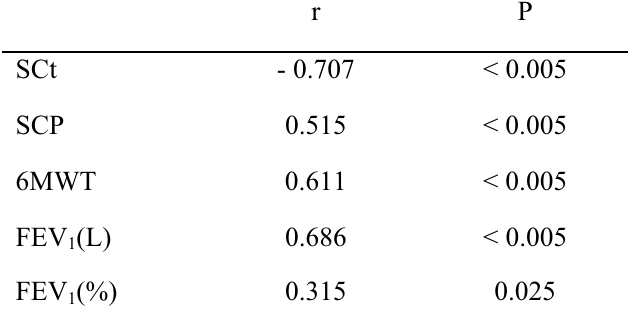
max and test variables ( r and p 2